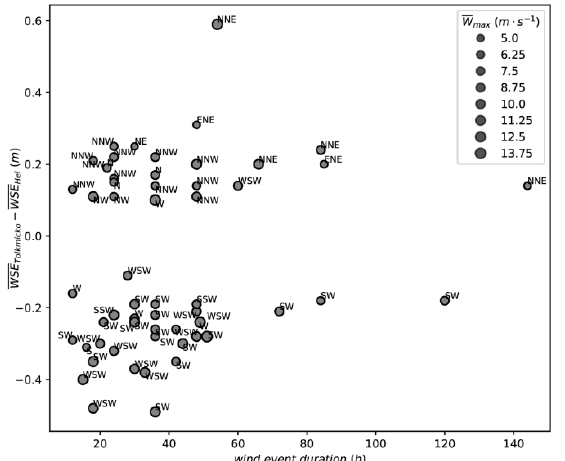
Figure 7. Difference between the average water levels (WSE) at Tolkmicko and Hel versus the wind event duration time. The label denotes the dominating wind direction, the size denotes the observed maximum wind speed.